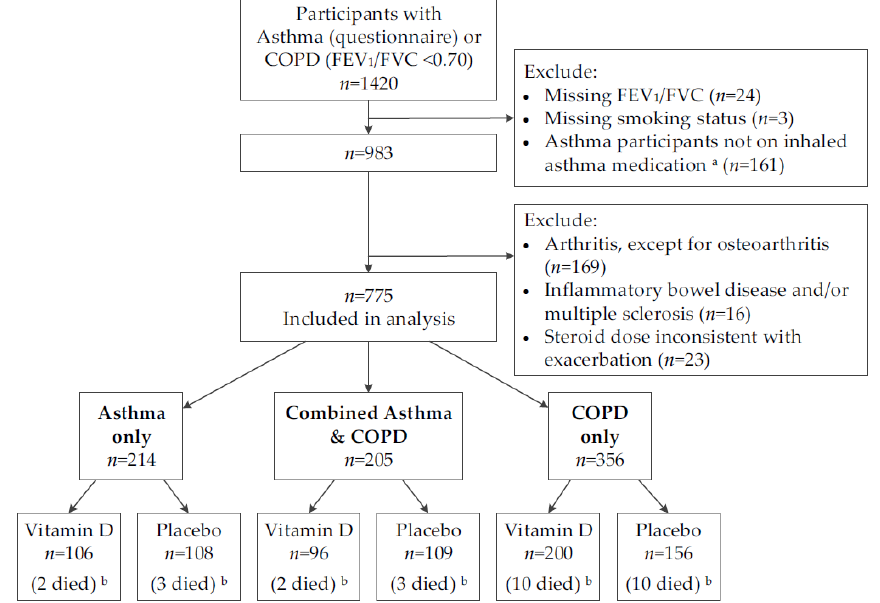
Figure 1. Flow diagram for selecting participants with asthma or chronic obstructive pulmonary disease in the ViDA study. COPD = chronic obstructive pulmonary disease; FEV 1 = forced expiratory volume in 1 s; FVC = forced vital capacity; SABA = short-acting β -agonist; LABA = long-acting β -agonist. a Dispensed inhaled corticosteroids, SABA or LABA at any time from 12 months before randomisation, to 36 months after. b Died by 31 July 2015.